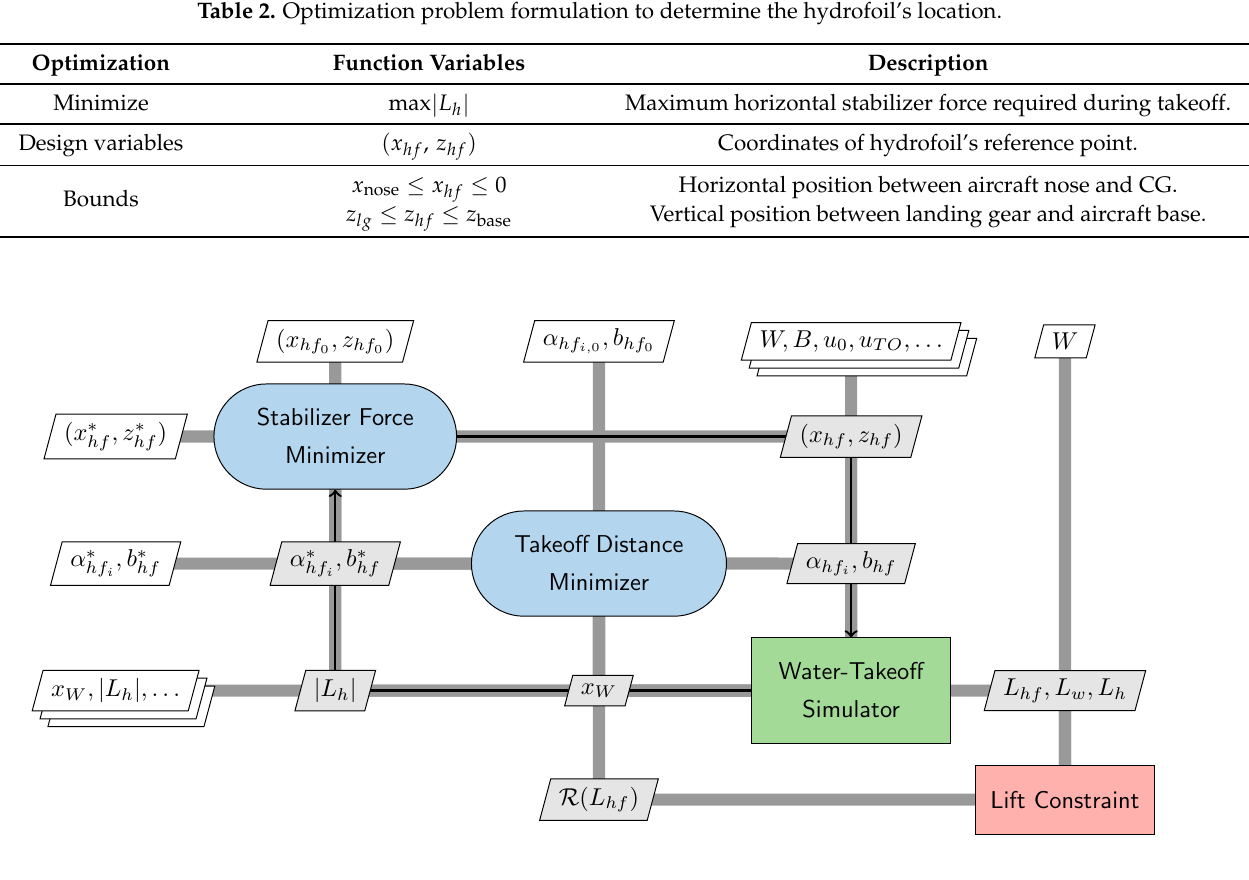
Figure 3. XDSM diagram for the hydrofoil location